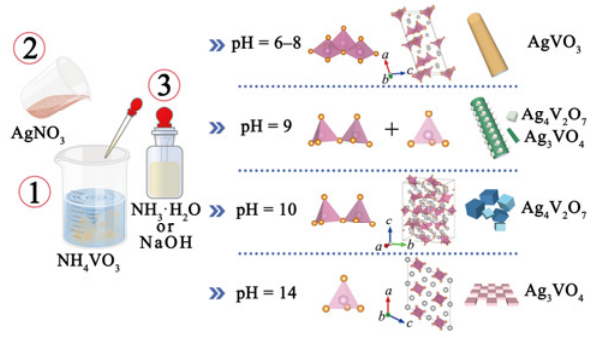
Fig. 1 Synthesis process of AgVO 3 , Ag 4 V 2 O 7 , Ag 3 VO 4 , and Ag 4 V 2 O 7 /Ag 3 VO 4 heterojunction.